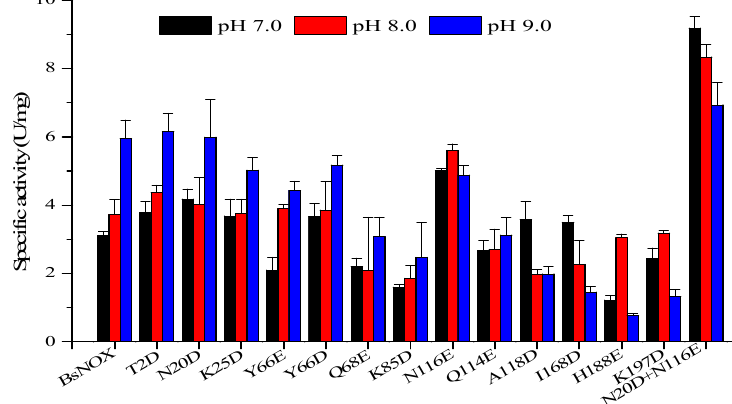
Figure 4. Effects of pH on the specific activity of BsNox and its variants.